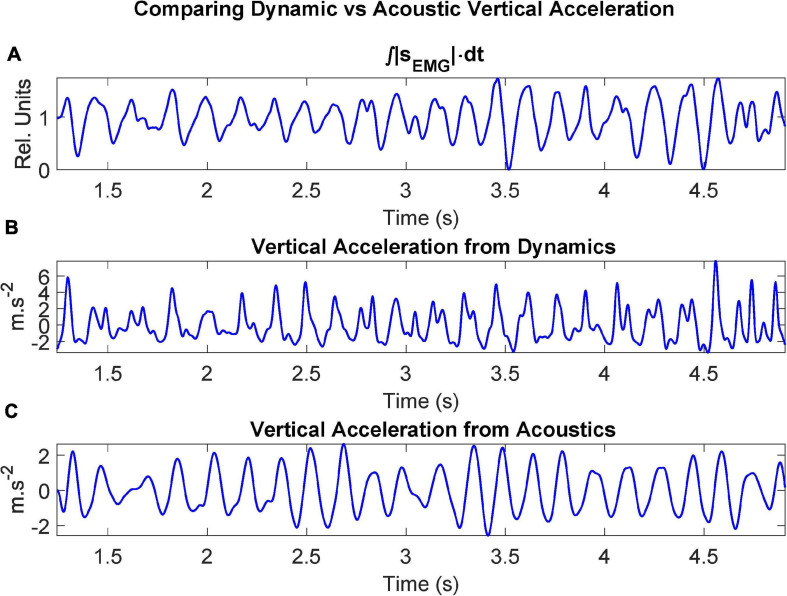
Dynamic signals after processing recordings from the control participant CMa when uttering the repetition of […aI…]: (A) ECMF (proportional to the force exerted by the muscle); (B) acceleration on the vertical axis after rotation (sagittal plane); (C) vertical acceleration estimated from the first two unbiased formants.